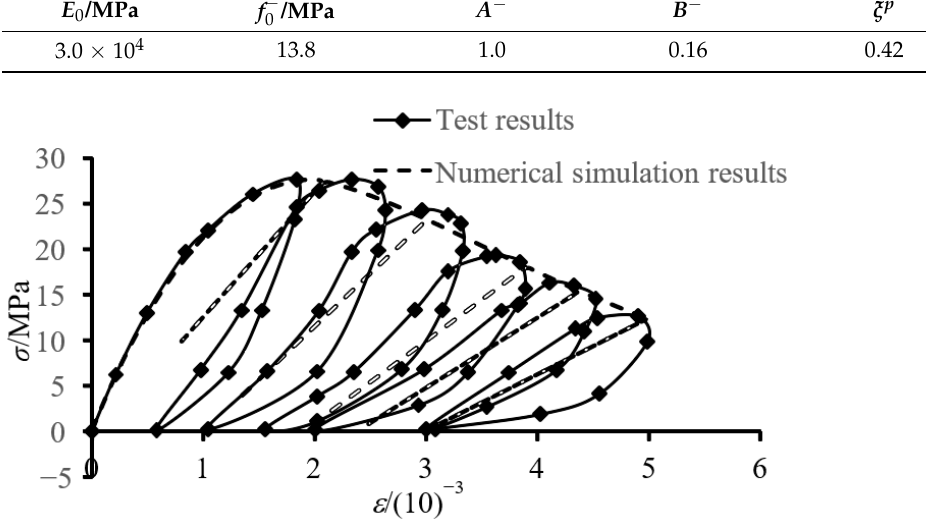
Table 5. Simulation parameters of cyclic compression test.